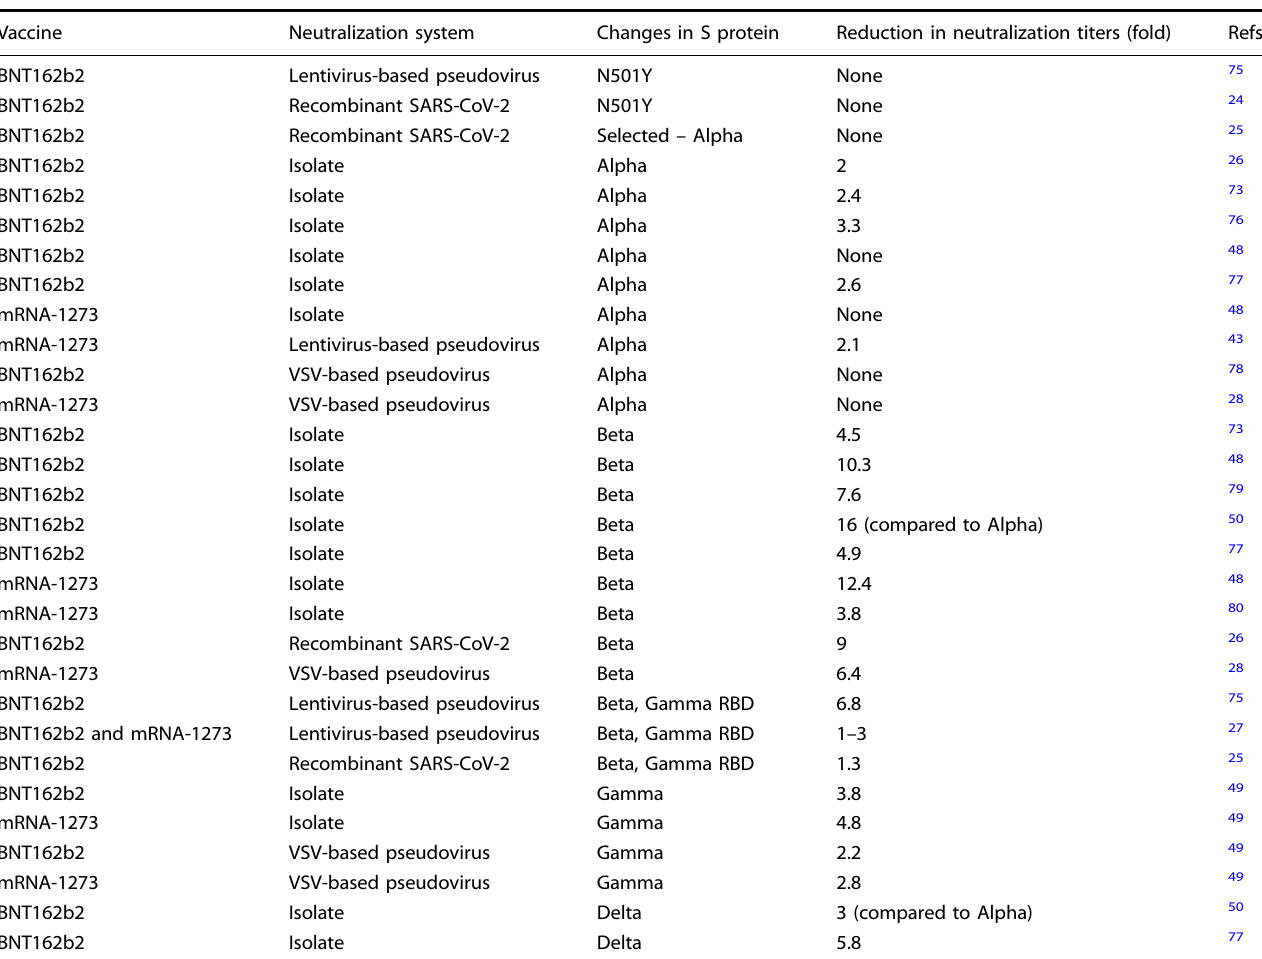
Table 1. Review of neutralization studies with sera elicited by mRNA-based